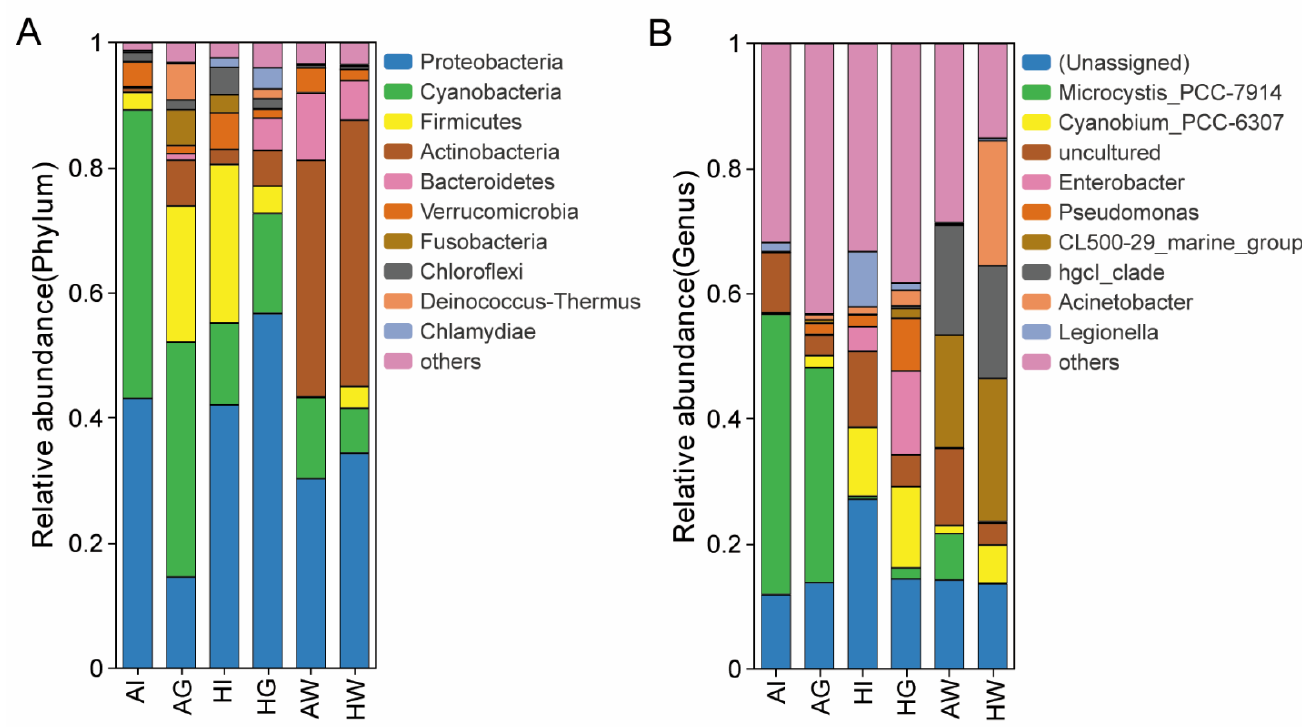
Figure 4. The microbial composition in all samples. ( A ) The abundances of top 10 phyla; ( B ) the abundances of top 10 genera. AI: intestinal samples of fish from zone A; AG: gill samples of fish from zone A; HI: intestine of fish from zone H; HG: gill of fish from zone H; AW: water samples from zone A; HW: water samples from zone H.